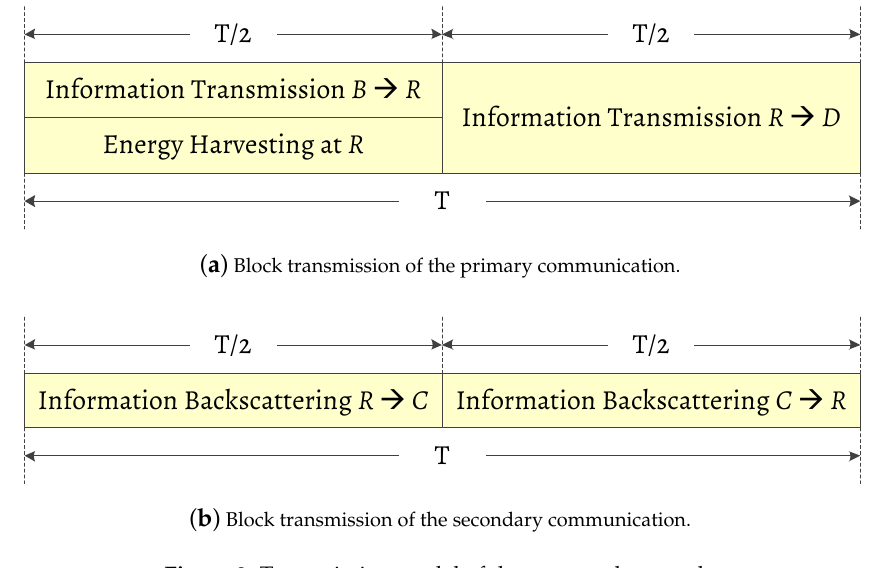
Figure 2. Transmission model of the proposed